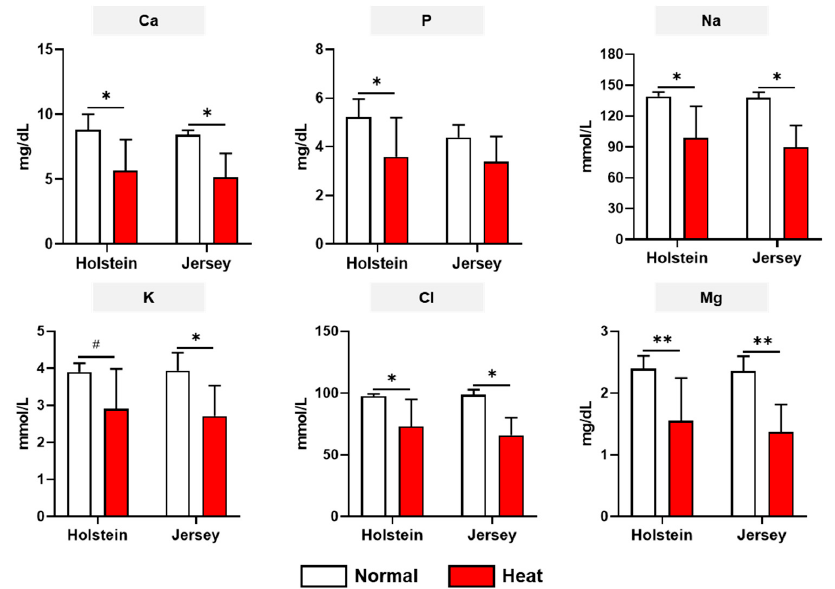
Figure 5. Changes in mineral concentrations in dairy cows under heat stress. Biochemistry analysis of Holstein and Jersey cows was conducted for mineral contents under normal and high-heat conditions. Data are represented as means ± standard deviation (SD); n = 7–8 animals/group. Values were statistically analyzed by a mixed-effects model with Tukey’s multiple comparison test. * p < 0.05, ** p < 0.01, and # p <